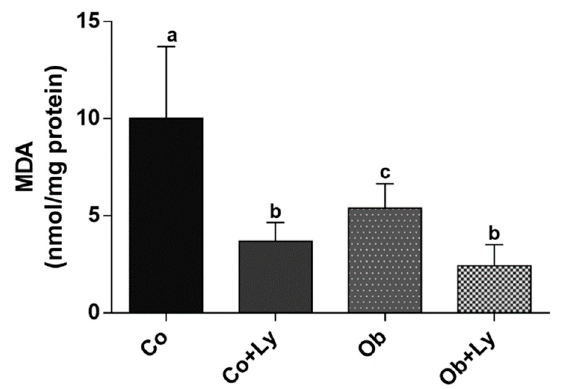
Figure 4. Assessment of lipid peroxidation through the quantification of malondialdehyde (MDA) in the liver: MDA (nmol/mg protein). Co: Control group; Co+Ly: Control group supplemented with lycopene; Ob: Obese group; Ob+Ly: Hypercaloric group supplemented with lycopene. Data parametric expressed in mean ± standard deviation. Comparison by two-way ANOVA with Holm-Sidak post-hoc. Different letters correspond to the significant statistical difference ( p < 0.05); n = 6 animals/group.